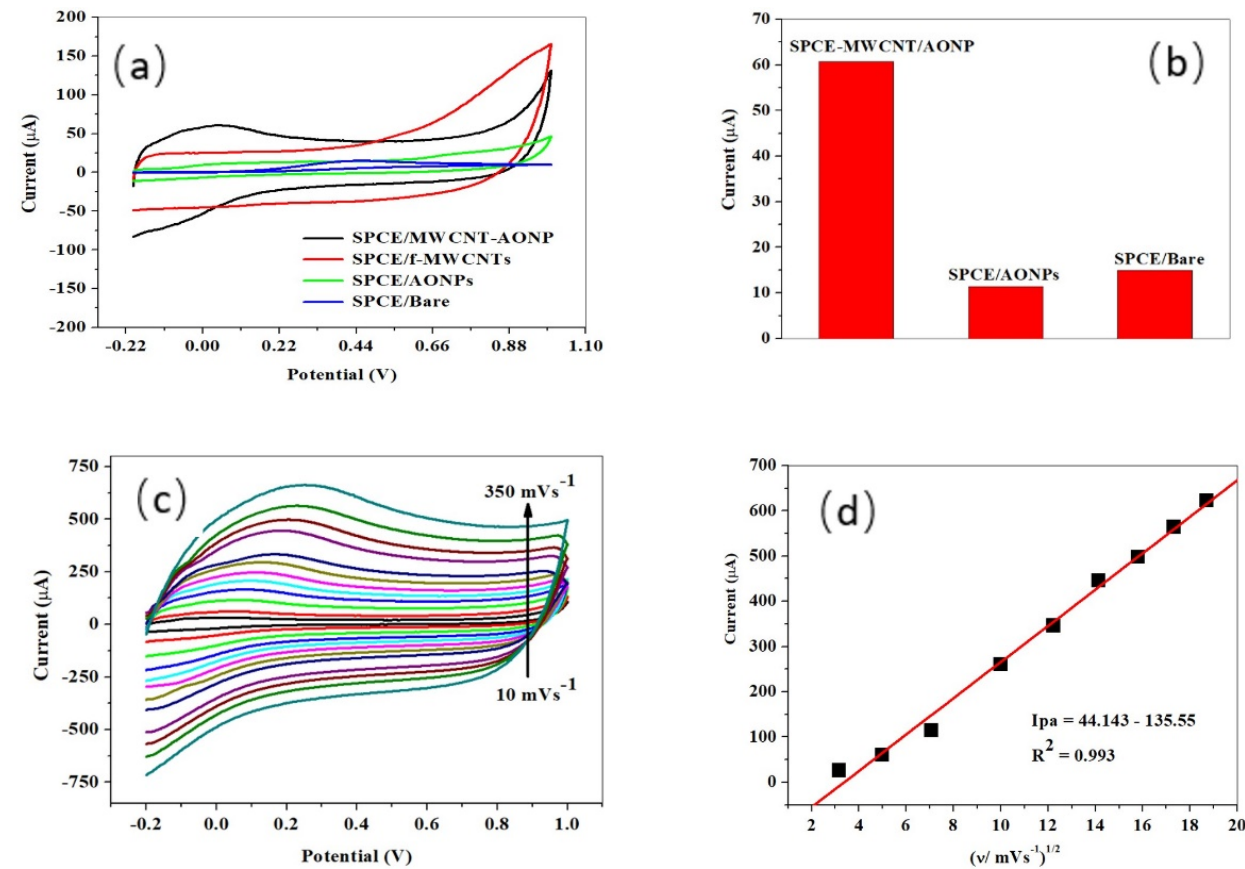
Figure 1. Comparative cyclic voltammograms at modified and bare electrode for ( a ) AA detection, ( b ) comparative currents response between bare and modified electrode, ( c ) scan rate study (10–350 mVs − 1 ), and ( d ) shows a linear relationship between Ipa vs. v 1/2 .